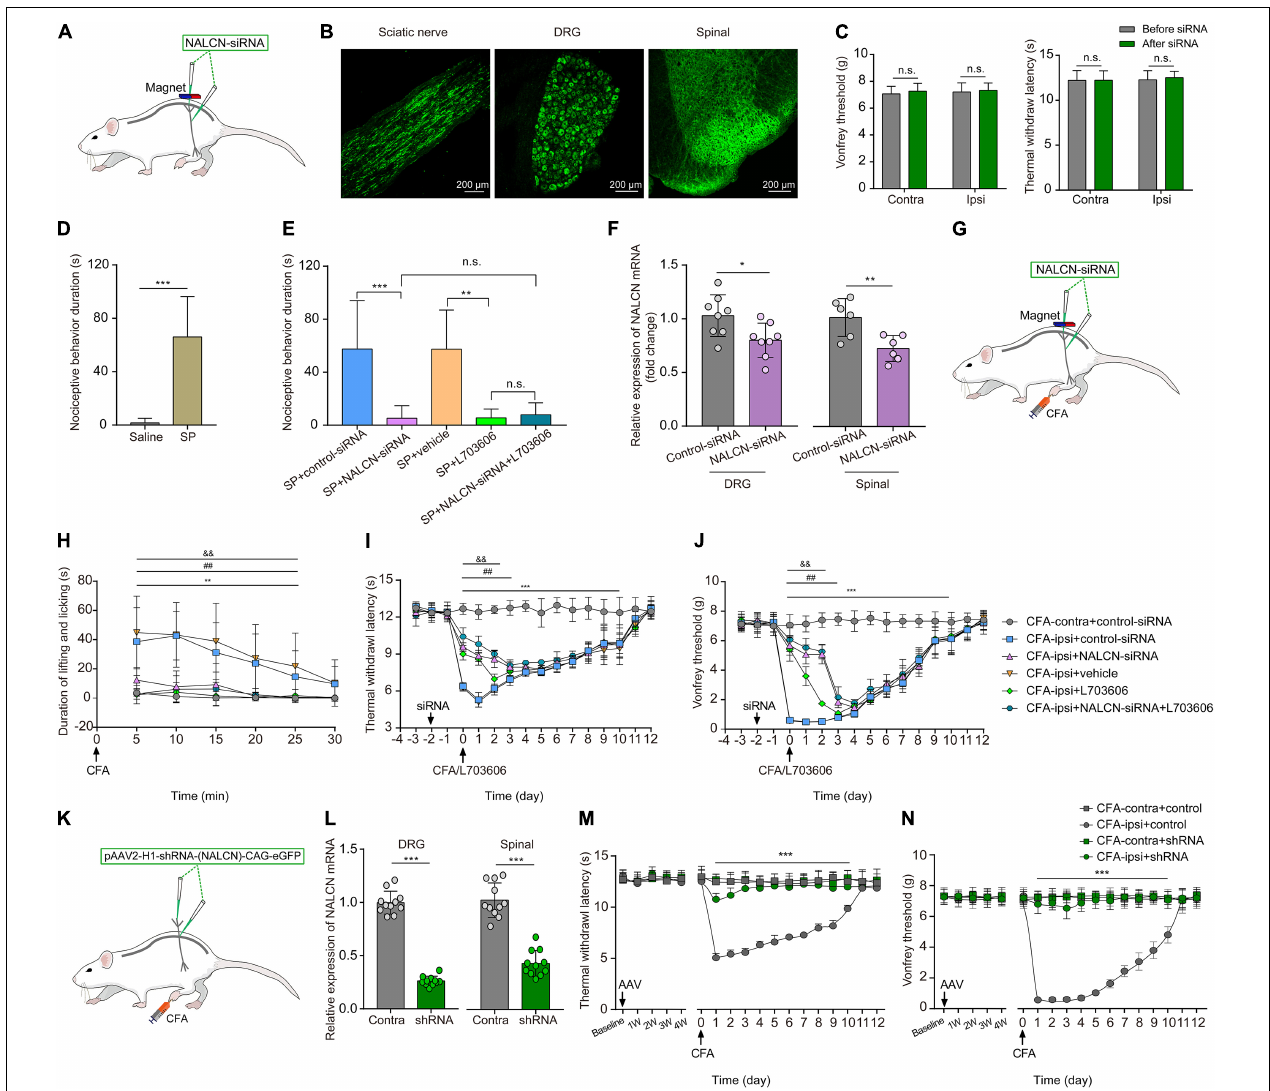
FIGURE 8 | The knockdown of expression of NALCN in DRG and spinal cord alleviates pain behaviors induced by SP or CFA. (A) siRNA administration methods used in adult rats. NALCN-siRNA and/or control-siRNA were intrathecally and intraneurally injected into the subarachnoid space and sciatic nerve in adult rats. (B) Alexa Fluor 488-positive fluorescence was found in sciatic nerve, DRG, and spinal dorsal cord after injection of NALCN-siRNA. (C) NALCN-siRNA did not affect the thermal hyperalgesia and mechanical allodynia of normal rats. (D) Intrathecal injection of SP induced pain-related behaviors in rats, including biting, licking, and scratching at the abdomen and hind portions of the body ( n = 10, unpaired t -test). (E) The duration of biting, licking, and scratching within the first 5 min after injection of SP decreased in the rats that received NALCN-siRNA, L703606, siRNA + L703606 ( n = 10, by two-way ANOVA, Holm–Sidak test). (F) The level of NALCN mRNA was decreased at day 3 after injection of NALCN-siRNA in DRG and spinal cord compared with control-siRNA ( n = 8–6, unpaired t -test). (G) Modeling and siRNA administration methods used in adult rats. NALCN-siRNA and/or control-siRNA were intrathecally and intraneurally injected into the subarachnoid space and sciatic nerve in adult rats. (H) NALCN-siRNA, L703606, and siRNA + L703606 alleviated spontaneous pain behavior (lifting/licking/flinching behaviors) within the first 25 min, following CFA injection ( n = 10, two-way repeated measures ANOVA, Holm–Sidak test). (I) NALCN-siRNA, L703606, and siRNA + L703606 alleviated thermal hyperalgesia at day 0–3 after CFA injection ( n = 10, two-way repeated measures ANOVA, Holm–Sidak test). (J) NALCN-siRNA, L703606, and siRNA + L703606 alleviated mechanical allodynia at day 0–3 after CFA injection ( n = 10, two-way repeated measures ANOVA, Holm–Sidak test). (K) Representative cartoons of pAAV2-H1-shRNA-(NALCN)-CAG-eGFP injection. (L) NALCN mRNA was decreased in DRG of the AAV-NALCN-shRNA group as compared with AAV-scrambled-shRNA group (left panel, n = 11, unpaired t -test). NALCN mRNA was decreased in dorsal spinal cord of the AAV-NALCN-shRNA group as compared with the AAV-scrambled-shRNA group (right panel, n = 11, unpaired t -test). (M,N) Normal sensory function in thermal test [ (M) , left panel, n = 10] or von Frey [ (N) , left panel, n = 10] was unchanged during the 4 weeks after AAV-NALCN-shRNA injection, compared with AAV-scrambled-shRNA or baseline. NALCN-shRNA alleviated thermal hyperalgesia [ (M) , right panel, n = 10, CFA-ipsi + shRNA vs. CFA-ipsi + control, two-way repeated measures ANOVA, Holm–Sidak test] and mechanical allodynia [ (N) , right panel, n = 10, CFA-ipsi + shRNA vs. CFA-ipsi + control, two-way repeated measures ANOVA, Holm–Sidak test] throughout after CFA, compared with scrambled shRNA. DRG: dorsal root ganglion; SP: substance P; CFA-contra: CFA-contralateral side; CFA-ipsi: CFA-ipsilateral side; ANOVA: analysis of variance. Data are presented as mean ± SD. * p < 0.05, ** p < 0.01, *** p < 0.001 CFA-contra + control-siRNA vs. CFA-ipsi + control-siRNA; ## p < 0.01 CFA-ipsi + control-siRNA vs. CFA-ipsi + NALCN-siRNA; && p < 0.01 CFA-ipsi + vehicle vs. CFA-ipsi +